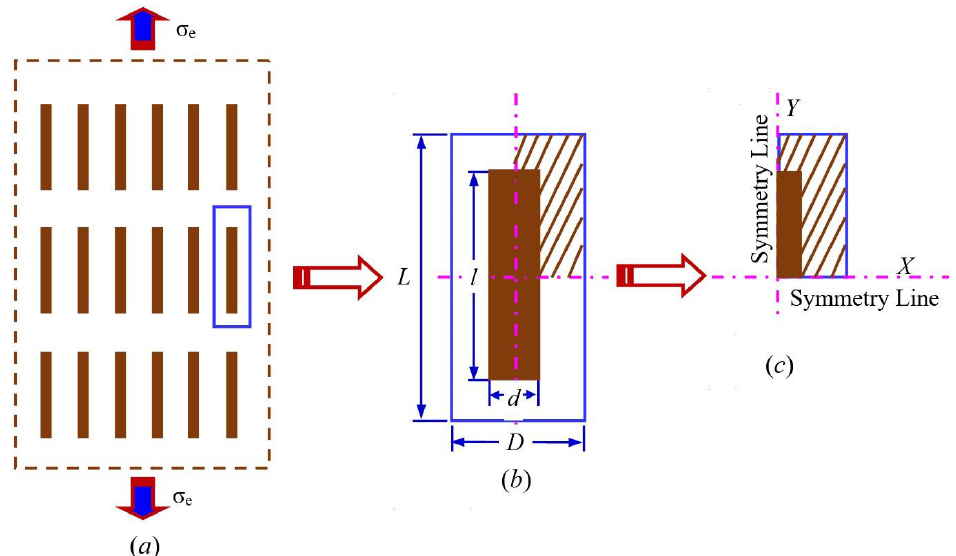
Figure 5. Representative volume element (RVE) of a PNC reinforced with aligned, identical clay nanoparticles in a stack distribution configuration. ( a ) Idealized identical stacking clay platelets; ( b ) a typical RVE; and ( c ) a quarter RVE for efficient simulation.